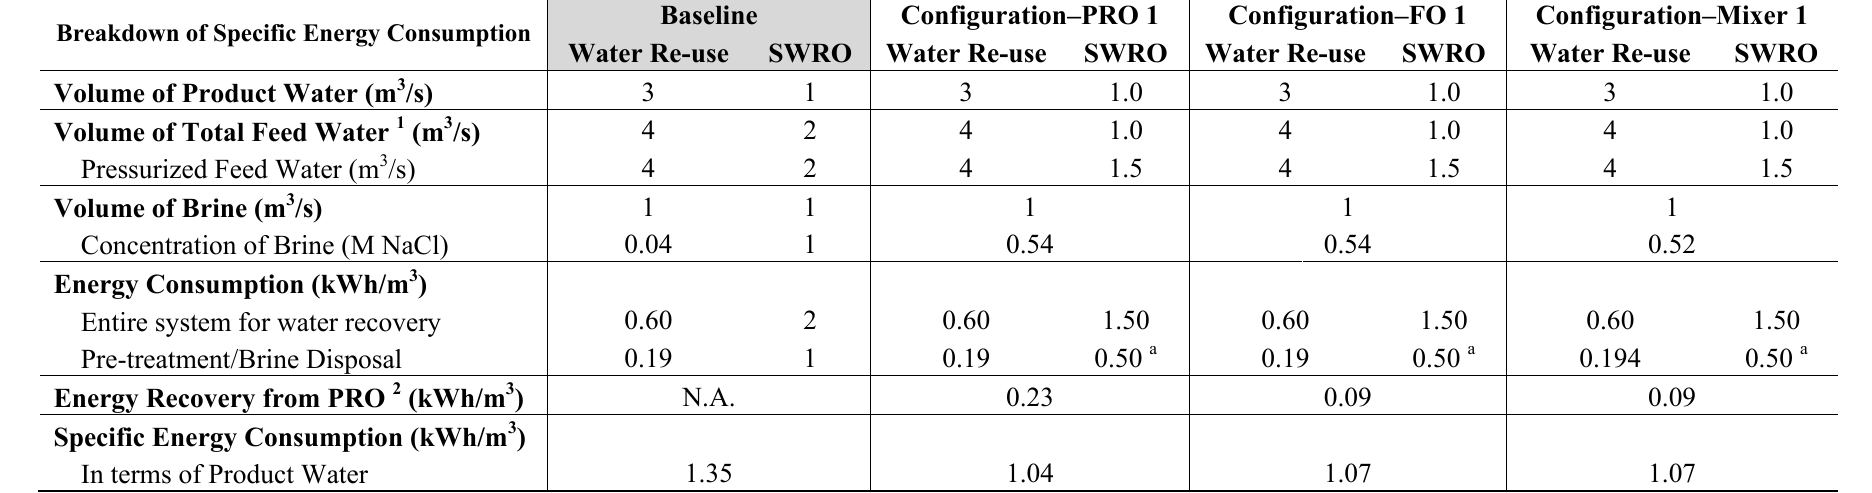
Table A3. Total energy consumption for baseline (Water Reuse and SWRO) and different